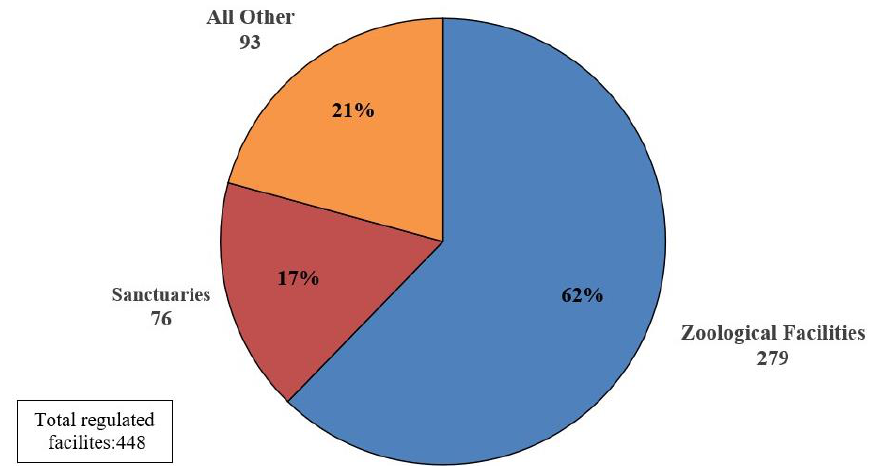
Figure 1. Federally regulated facilities holding big cat species, sorted by business type.